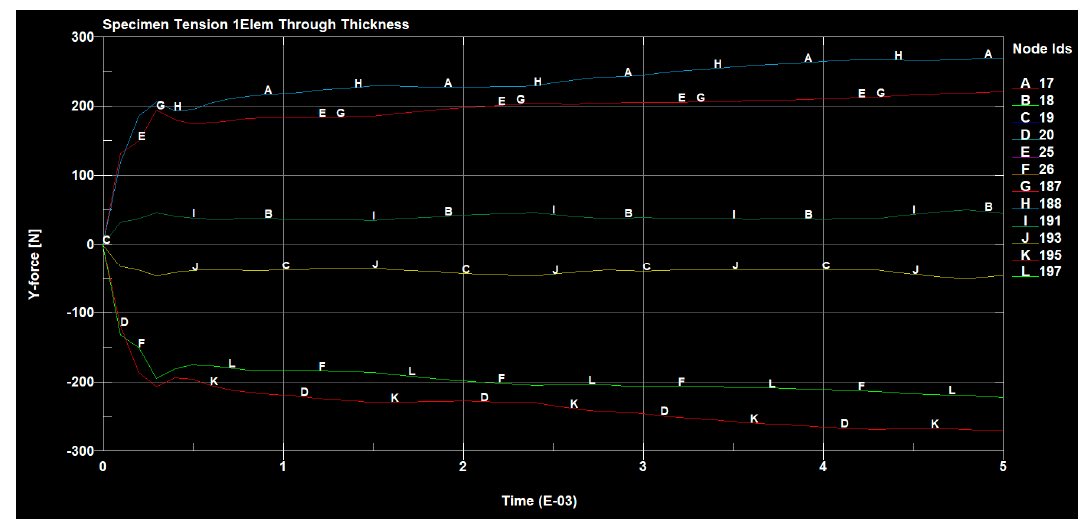
Figure 30. Tensile forces occurring on the sample in the 𝑥 direction.